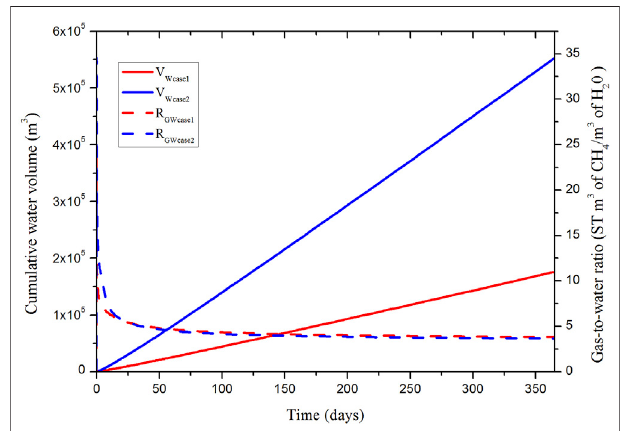
FIGURE 6 | Time-varying curve of V Wcase1 , V Wcase2 , R GWcase1 , and R GWcase2